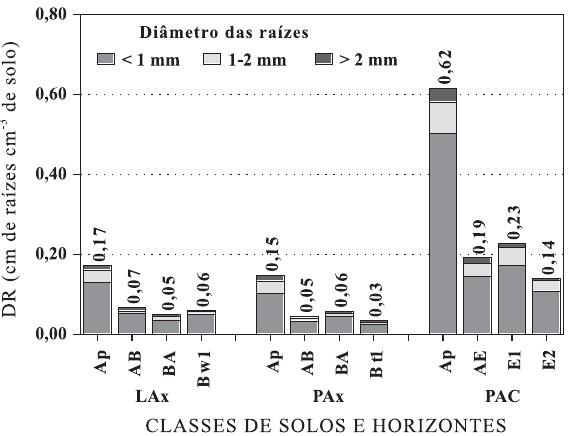
Figura 3. Valores médios de densidade de raízes da laranjeira ‘Hamlin’ enxertada em limoeiro ‘Cra- vo”, em três classes de diâmetro, por